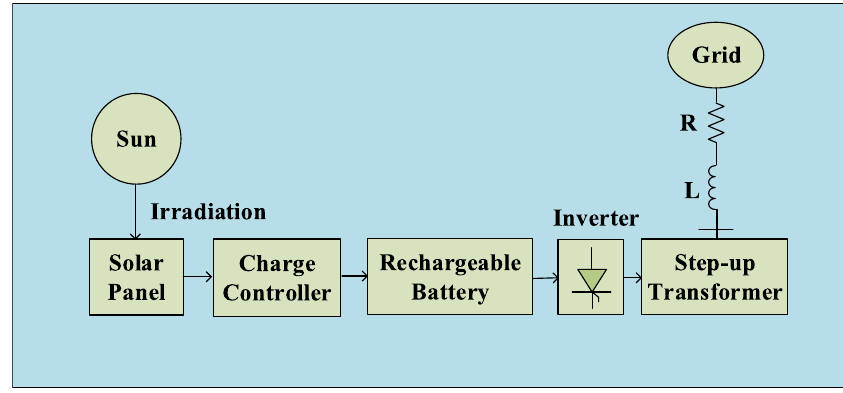
Fig. 9 Solar Energy Generation Process